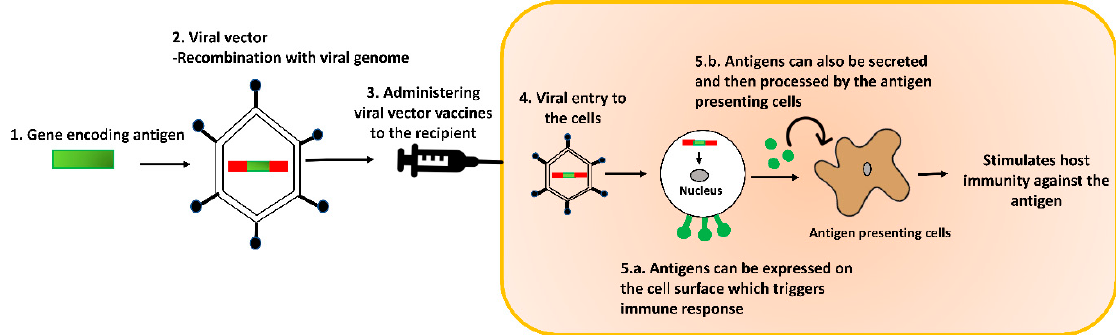
Figure 4. Illustration of viral vector vaccine delivery method. The gene encoding the antigen of interest can be introduced into the viral genome via recombination. The recombinant viral vectors can be administered to the recipient. Upon entry into the recipient cells, they release the viral genome into the cytoplasm. This results in the in vivo expression of the encoded antigen. The antigen can either be expressed on the cell surface, or secreted and then processed by antigen-presenting cells.